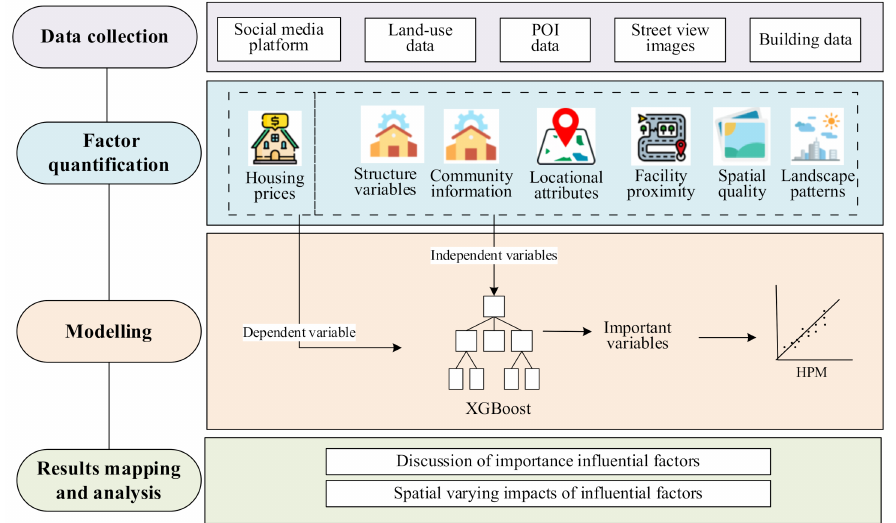
Figure 1. Overall methodological